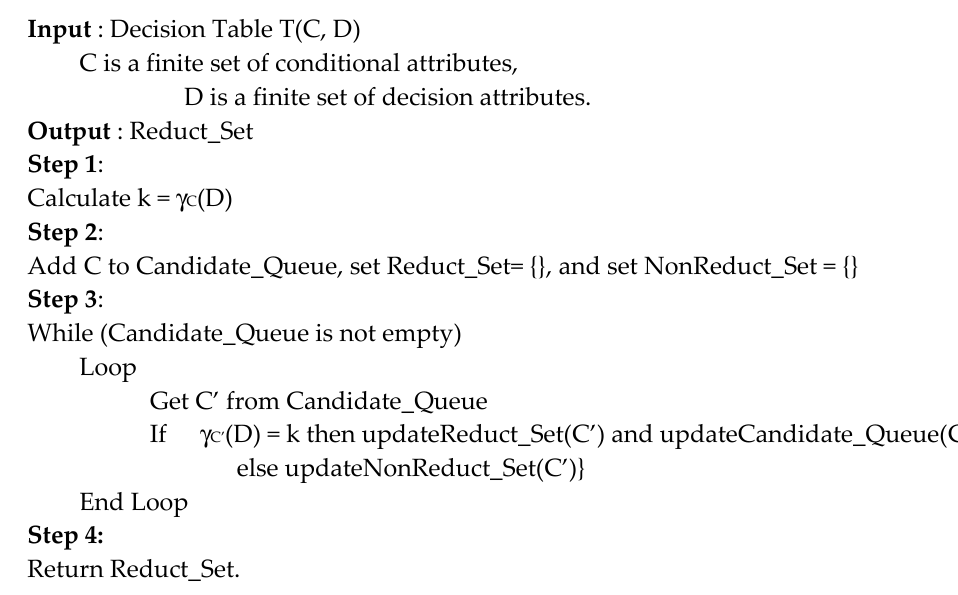
Figure 1. Efficient breadth-first reduct search algorithm.